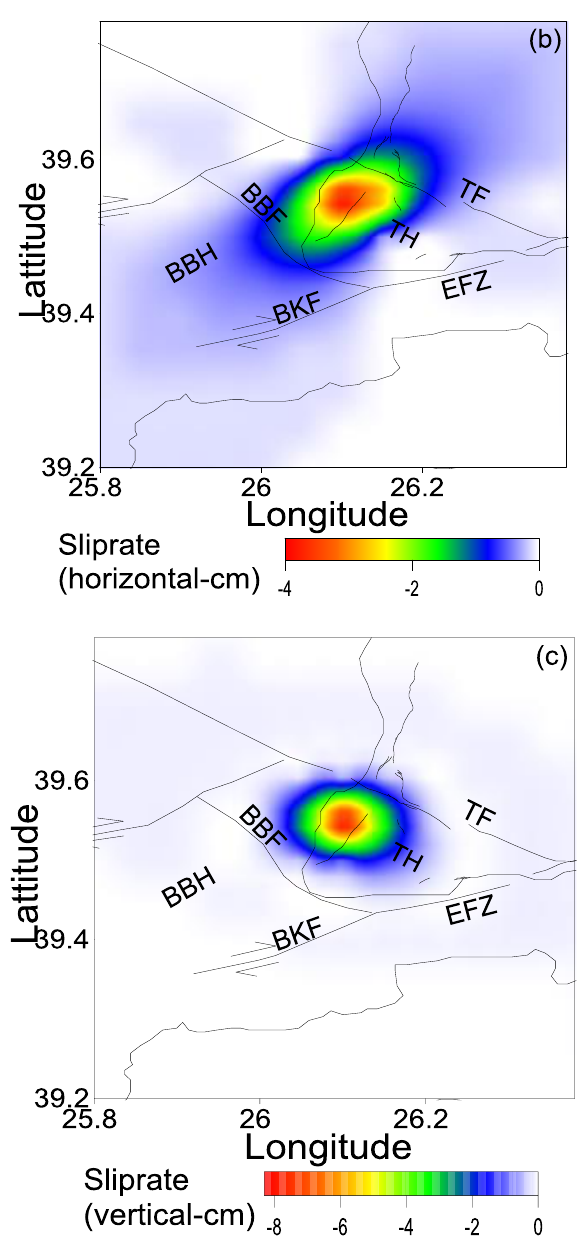
Figure 7. (a) Coulomb stress changes (Bar), (b) Horizontal sliprate (cm) and (c) Vertical sliprate